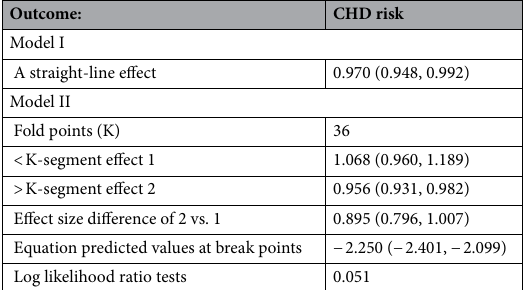
Table 4. Threshold effect. Independent variable: serum albumin; dependent variable: coronary heart disease (CHD). Results are expressed as OR (95% CI). Adjust for: Gender; Age; Race; Diabetes; HDL-C; Hypertension; LDL-C; Creatinine.